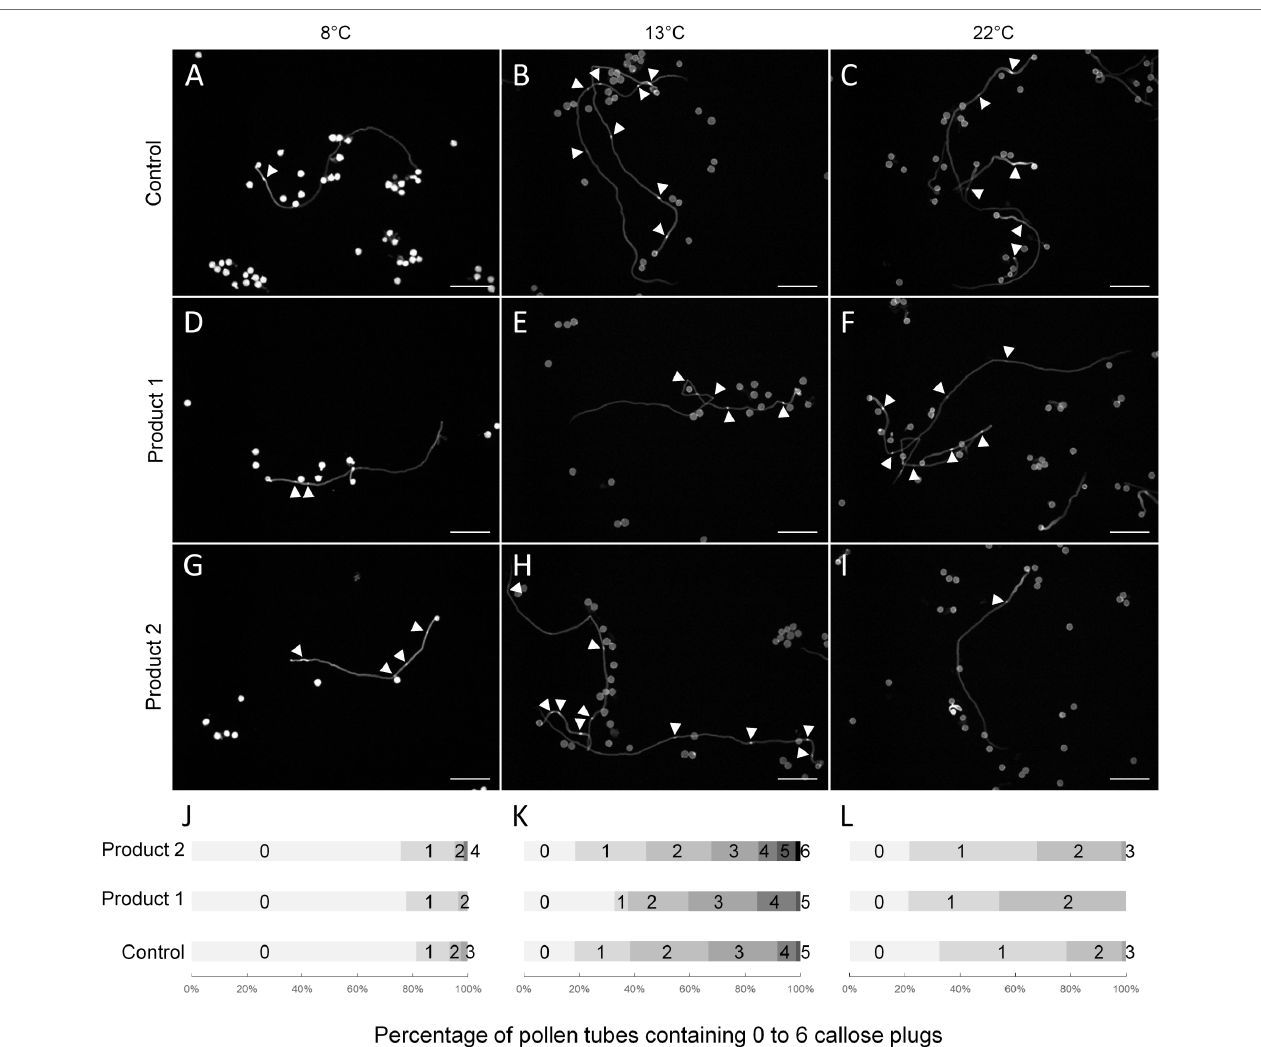
FIGURE 4 | Impact of temperatures and treatments on callose plug deposition in tomato pollen tubes. (A–I) Representative pictures of aniline blue stained pollen tubes cultivated for 4*D at 8 (A,D,G) , 13 (B,E,H) , or 22 ° C (C,F,I) in the control condition (A–C) or in a medium supplemented with 2 μ g.ml − 1 of P1 (D–F) or P2 (G–I) . (J–L) Percentage of pollen tubes containing 0 to 6 callose plugs in the control condition or in a medium supplemented with 2 μ g.ml − 1 of P1 or P2 at 8 (J) , 13 (K) , and 22 ° C (L) . Arrowheads show callose plugs. Scale bars = 200 μ